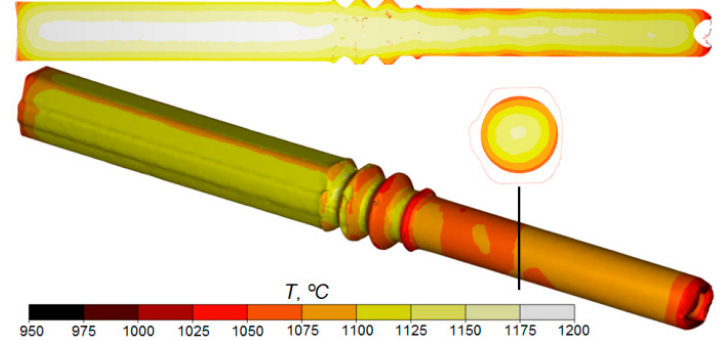
Figure 9. FEM temperature distribution in a workpiece rolled in the helical pass of the skew rolling mill.